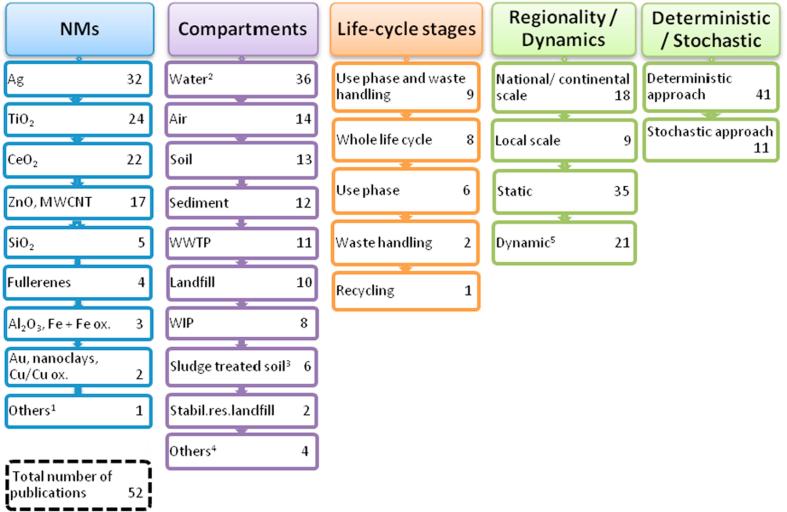
Summary of the landscape of environmental exposure models. The total number of models corresponds to the total number of entries in the inventory (52). 1MNs include organo-silica, hydroxyapatite, latex, CuCO3, quantum dots, carbon black, Ca peroxide, keratin fibers and Al. These MNs only appear once in the inventory. 2Includes surface water, rivers, natural freshwater and drinking water. 3Also including agricultural soil. 4Include incinerated ash landfill, groundwater, drinking water plant, human body, lungs, swimming pools and bioactive landfill, marine biota, vegetation and agricultural soil. 5The dynamic modelling of release describes the evolution over time of the amounts of MNs released to the environment, including also dynamic model outputs.